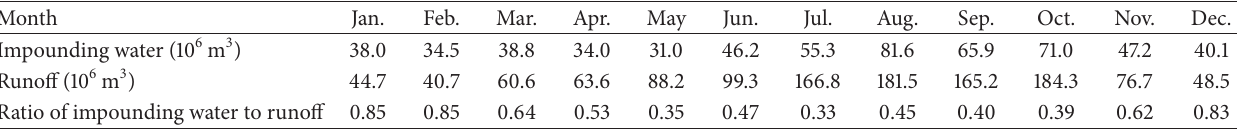
Table 4: Comparison of impounding water by dams and the runoff in Baoji area [23].